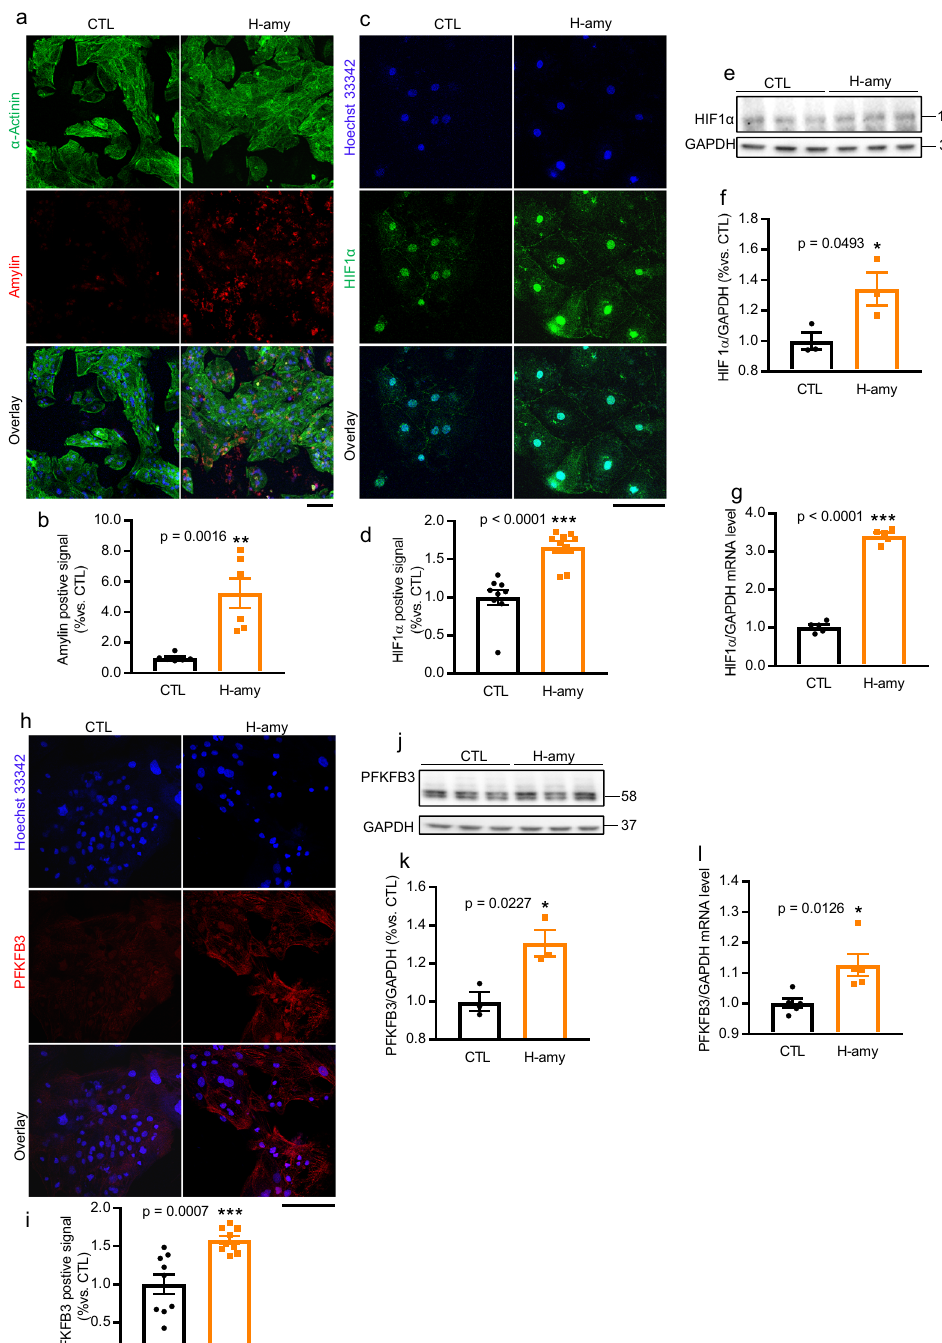
Fig. 5 Cardiac amylin accumulation activated HIF1 α and PFKFB3 in hiPSC-CMs. a Immunostaining of α -actinin ( a , green color, mouse anti- α -Actinin antibody), positive signal of human amylin ( a , red color, rabbit anti-human amylin antibody) and Hoechst 33342 (blue color) in cells treated with H-amy and b quanti fi cation of amylin positive signal was shown in bar graph ( n = 6/group). c – l Expression of HIF1 α ( c – g ) and PFKFB3 ( h – l ) in hiPSC-CMs treated with CTL and H-amy. Positive signal of HIF1 α ( c , green color, mouse anti-HIF1 α antibody), PFKFB3 ( h , red color, rabbit anti-PFKFB3 antibody) and Hoechst 33342 ( c and h , blue color) levels were quanti fi ed as shown in bar graph ( d , HIF1 α ; i , PFKFB3, n = 9/group). Western blot analysis of HIF1 α ( e , f ) and PFKFB3 ( j , k ) in hiPSC- CMs incubated under the two conditions described in panel ( c ) ( n = 3/group). qRT-PCR of HIF1 α ( g ) and PFKFB3 ( l ) in myocytes incubated with CTL and H- amy ( n = 5/group). Scale bar, 100 µ m. Data represent mean ± SEM. * P <0.05, ** P <0.01, *** P <0.01 by Student ’ s t